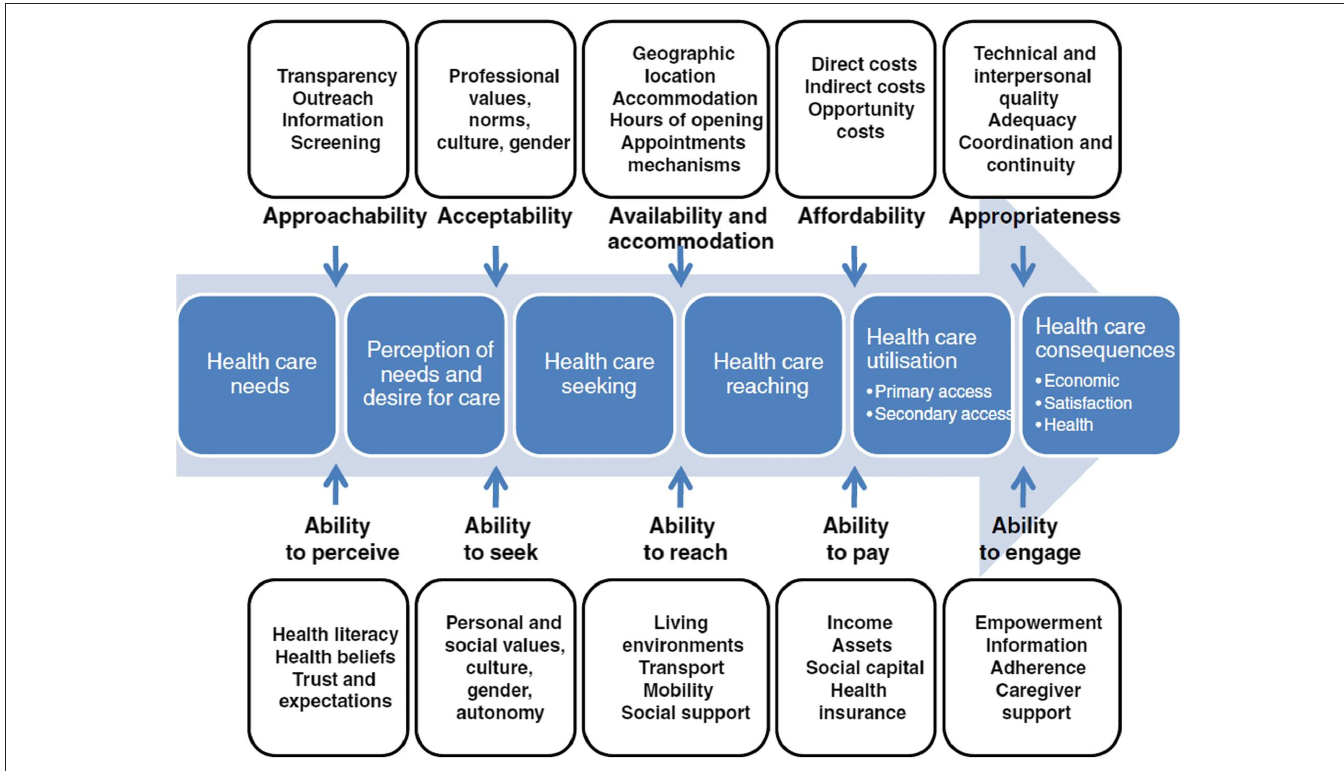
Figure 1 The conceptual diagram of the barriers and abilities required to achieve the benefits of primary care. Source: Levesque et al